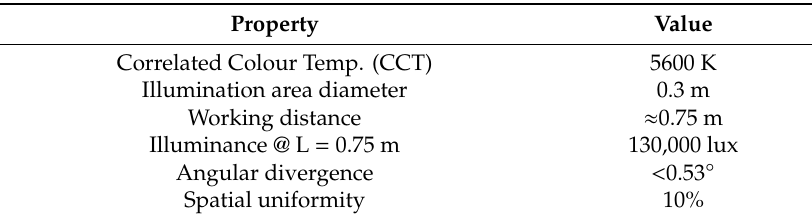
Table 4. Sun simulator design parameters.